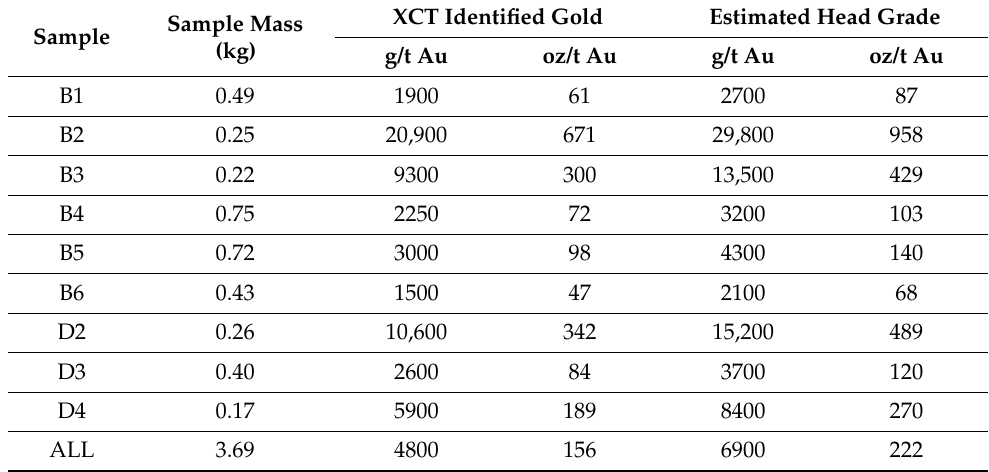
Table 14. Estimated grade of XCT samples. The XCT identified grade is based solely on the >200 µ m gold. The estimated head grade is the XCT grade plus 30% <200 µ m